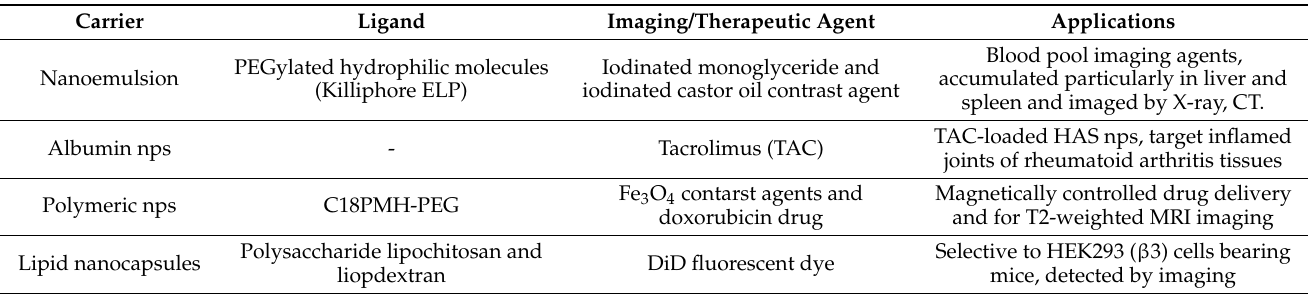
Table 3. Selected EPR -based therapeutic